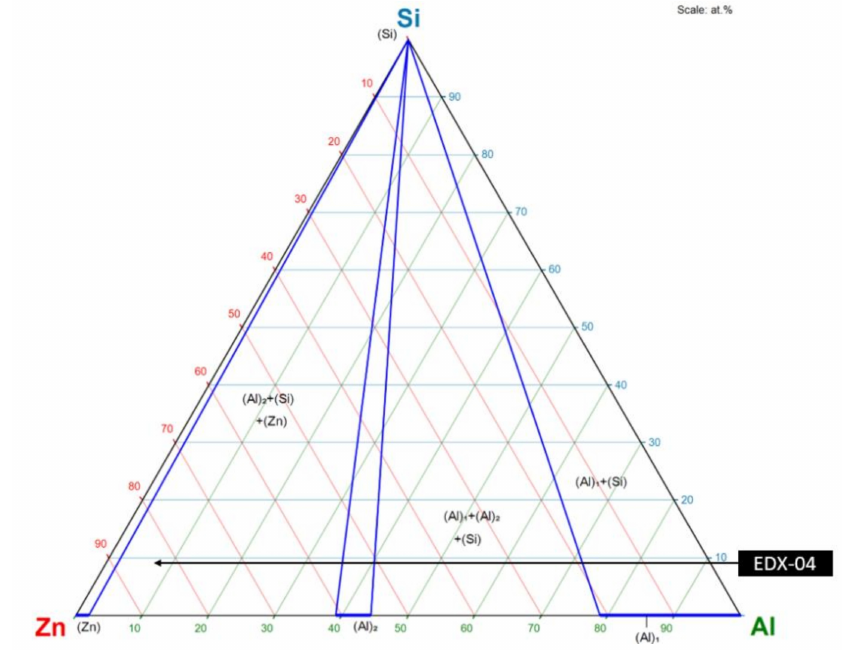
Figure 9. Isothermal section of the ternary system Al-Si-Zn at 300 ◦ C with EDX point